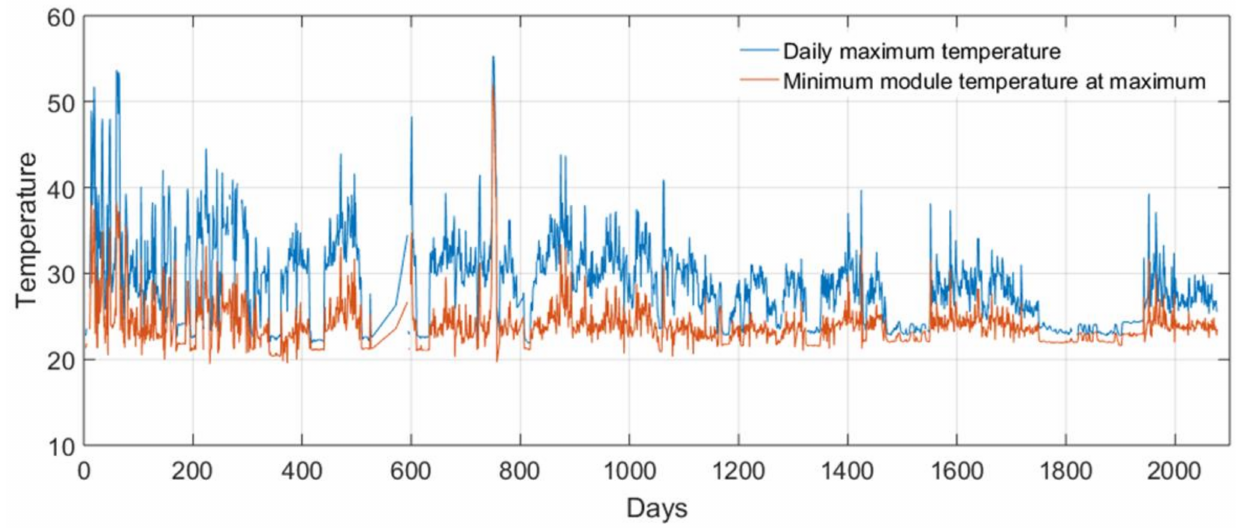
Figure 8. Maximum daily temperature evolution with associated minimum module